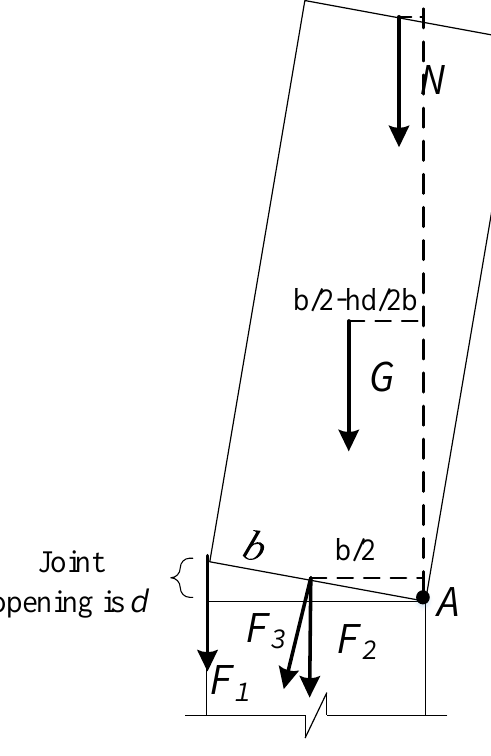
Figure 21. Ultimate stress state of pier bending.